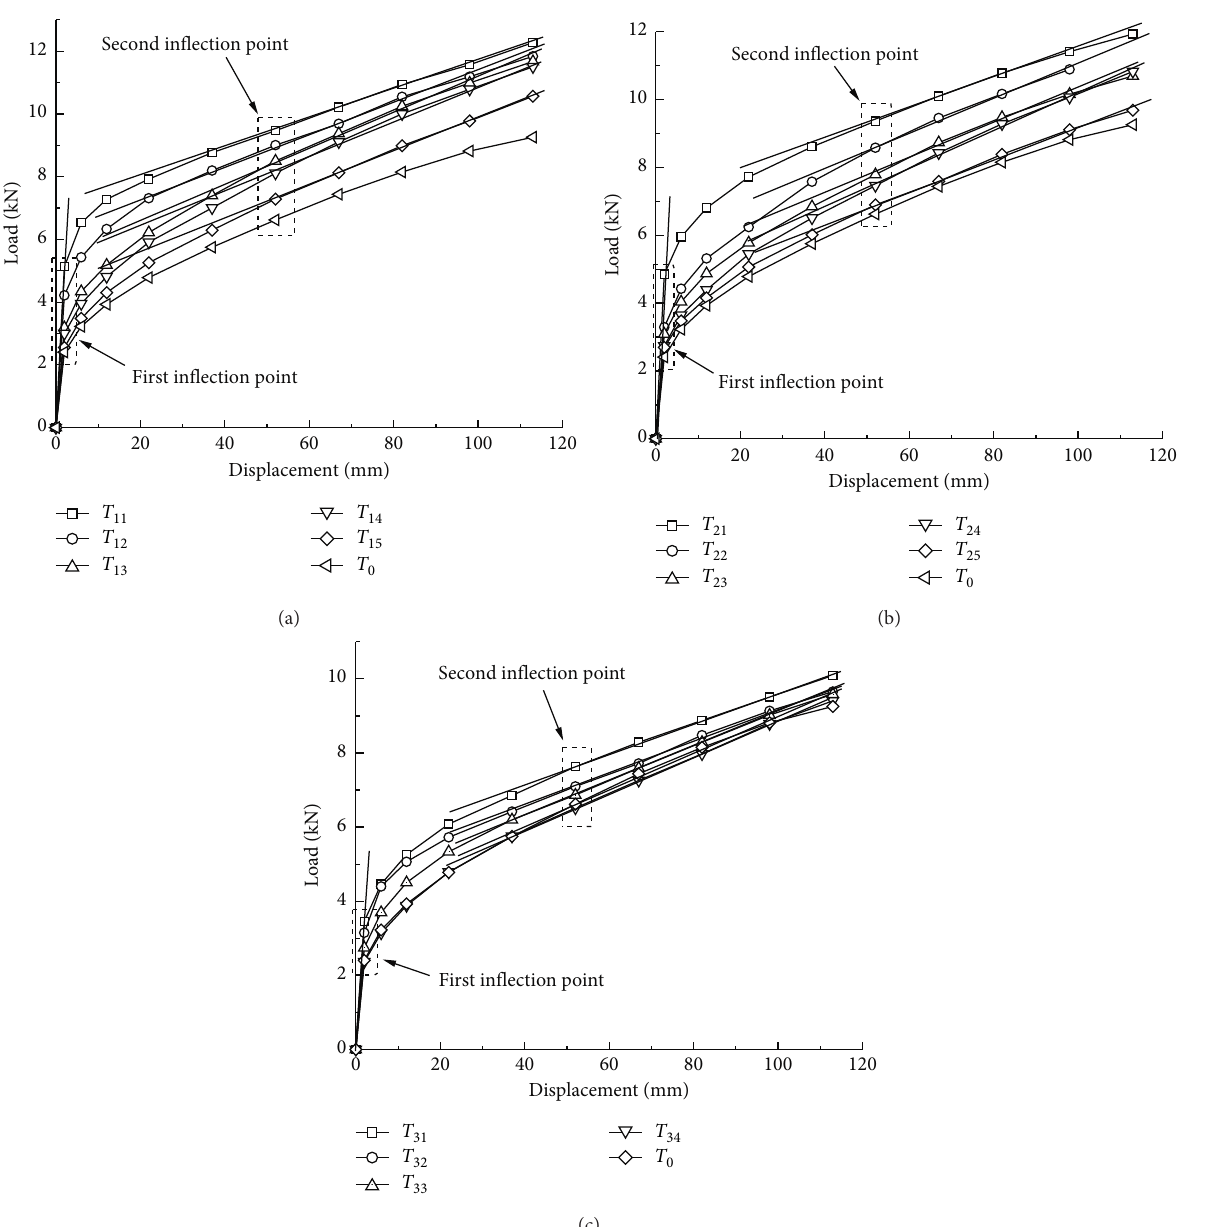
Figure 6: Uplift load and displacement curve with different layout spacing: (a) BPG, (b) SPG, and (c)